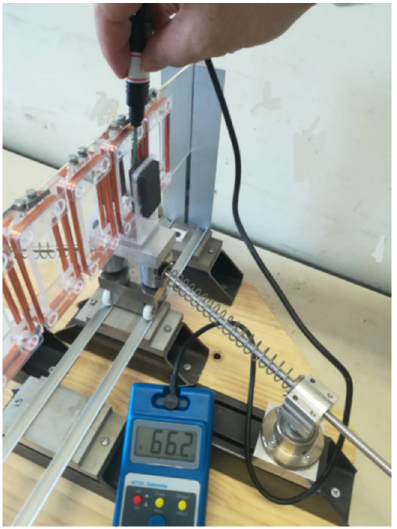
Figure 7. Measurement of flux density of magnetic field around coil.